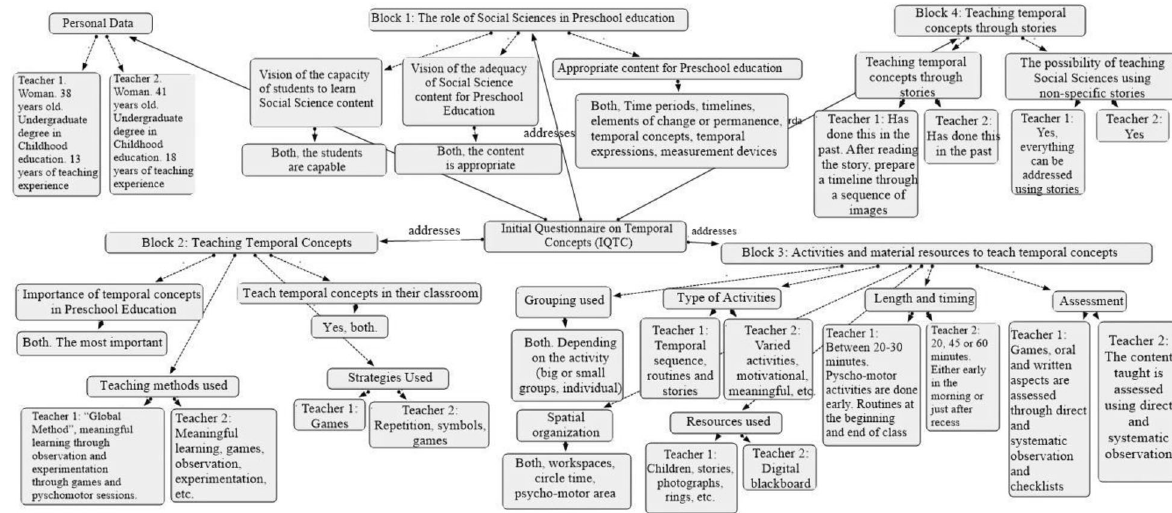
Fig. 2 Semantic network from the Initial Questionnaire on Temporal Concepts (IQTC). This fi gure shows a semantic network linking the Initial Questionnarie on Temporal Concepts with the answers of the